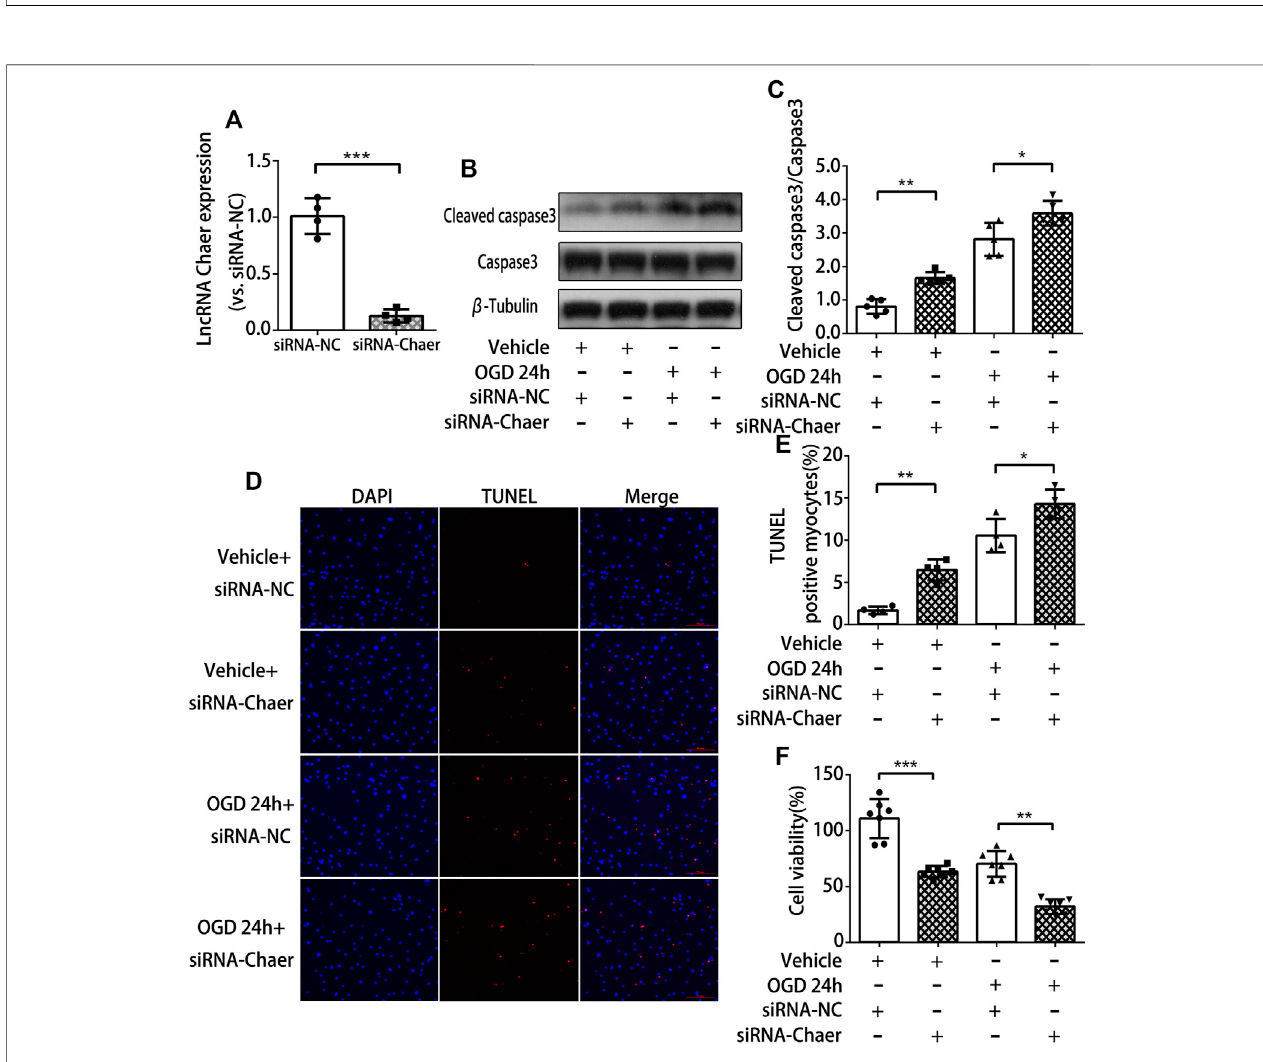
FIGURE 2 | Downregulation of lncRNA Chaer increases apoptosis in cardiomyocytes treated with OGD. (A) Knockdown of lncRNA Chaer with SiRNA Chaer in cardiomyocytes. ***p < 0.001 vs. siRNA-NC, n (cid:1) 4. (B, C) After SiRNA transfection, CMs were treated with OGD for 24 h, then western blotting was applied to test the expression ofapoptosis-relatedprotein caspase3 and cleaved caspase 3in cardiomyocytes. *p < 0.05, **p < 0.01, n (cid:1) 5. (D,E) Representative TUNEL-stainedimages of siRNA-Chaer-infected cardiomyocytes after treatments of OGD. Red, TUNEL-positive nuclei; blue, DAPI; scale bar (cid:1) 50 μ m. Quanti fi cation of TUNEL-positive cardiomyocytes. *p < 0.05, **p < 0.01, n (cid:1) 4. (F) Effect of siRNA-Chaer on cell viability after 24 h OGD treatments by CCK8 analysis. **p < 0.01, ***p < 0.001, n (cid:1) 7.